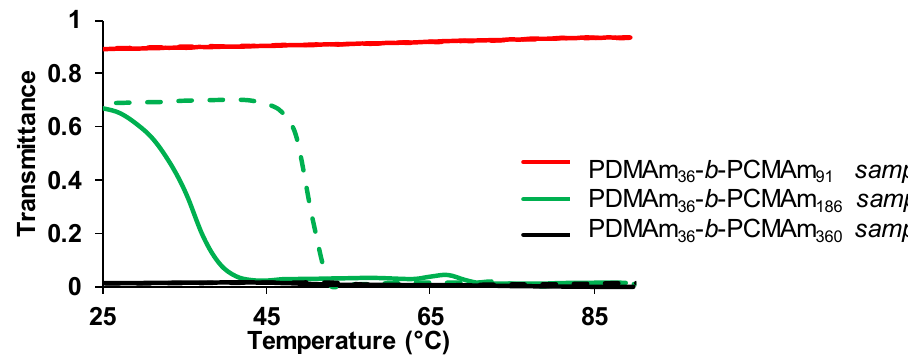
Figure 4. Turbidity curves of PDMAm- b -PCMAm dispersions prepared at 1 wt% in water ( λ = 670 nm, 1 °C min − 1 ) (Table 1). First cooling: solid lines; second heating: dashed lines.